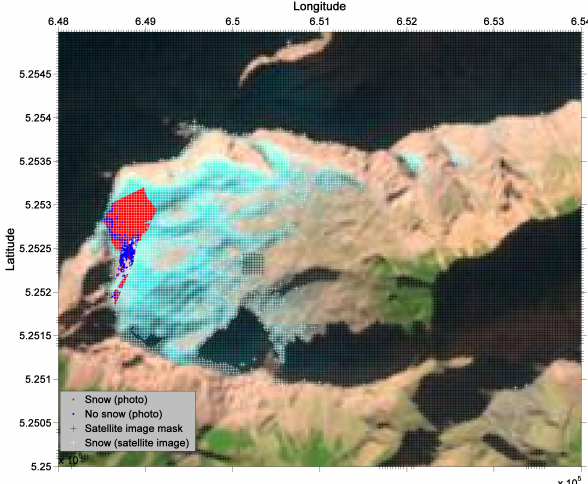
Figure 7. Resulting snow cover maps of the SLR photograph and the Landsat 7 ETM + image on 17 November 2011 for the Zugspitze massif superimposed on the Landsat Look image: snow cover is il- lustrated in red and areas free of snow in blue for the photographed area. Unsure photo classification results are not shown for reasons of clarity even though used in the NDSI threshold calibration. White crosses depict snow cover in the satellite data using the calibrated NDSI threshold of 0.18. Masked areas including clouds and shad- ows are displayed with black crosses. Areas in the Landsat Look image not superimposed with crosses are snow-free satellite